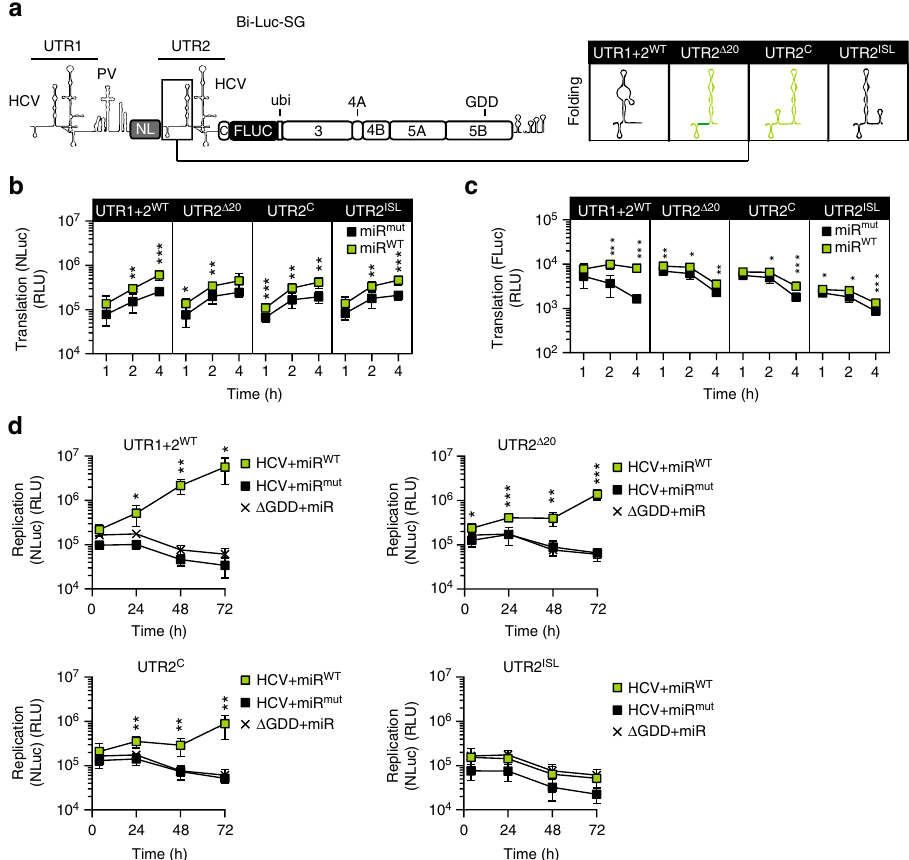
Fig. 5 Translation stimulation by DI mutations in the Bi-Luc context. a Schematic representation of the dual-luciferase construct (Bi-Luc-SG) and insertion region of the mutations (black box). The in silico predicted MFE structures of the inserted mutants are given in the table on the right. Mutants enhancing SLII formation are depicted in green. b , c Translation assay of selected mutants cloned into UTR2. The activity of Nano and fi re fl y luciferase was measured in presence of miR mut or miR WT . d Assessment of the full intracellular replication cycle of the dual luciferase constructs after electroporation with miR mut or miR WT . Replication was monitored via the Nano luciferase signal. Mean values (±SD), n = 3, in technical duplicates. RLU relative light units, Δ GDD replication-de fi cient mutant. * P < 0.05, ** P < 0.01, *** P <